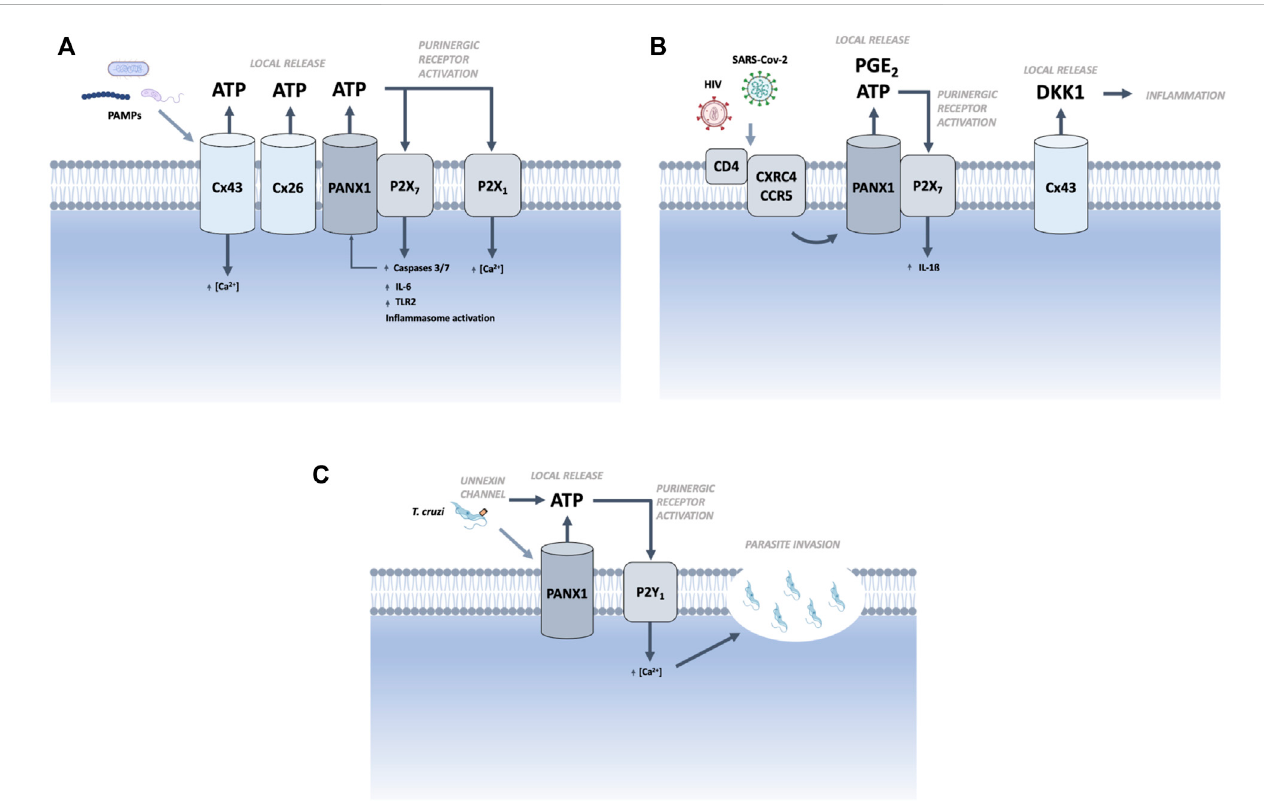
Proposed mechanism of contributions of large-pore channels to in fl ammation induced by microorganisms. (A) Extracellular bacteria or their toxins induce opening of Cx43, Cx26, and Panx1 hemichannels in host cell, causing an out fl ow of ATP. Extracellular ATP binds to speci fi c purinergic receptors, enhancing in fl ammation. The opening of the Cx43 hemichannel allows for the entry of Ca 2+ . (B) Through the activation of CD4-CXCR4/CCR5, the virus induces the opening of Cx43 and Panx1 hemichannels in the host cell, causing an out fl ow of ATP, PGE 2 , and DKK1. (C) Trypanosomatids induce the opening of Panx1 hemichannels in the host cells, causing local ATP release. Through the activation of the P2Y 1 receptor, ATP increases intracellular calcium ions and consequent invasion. The presence of hemichannels formed by unnexins in the parasite could be a tentative source of ATP. Figure was created with